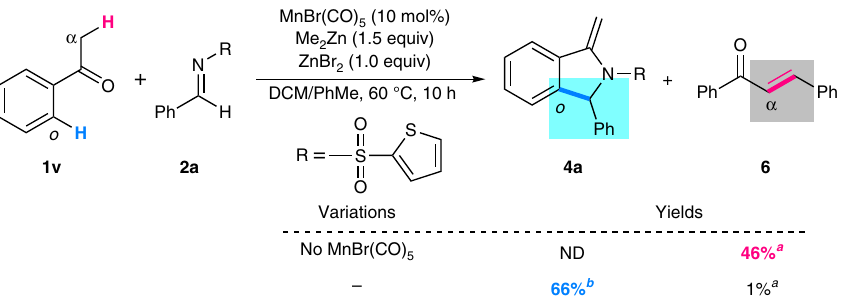
Fig. 2 Evaluating the C – H bond selectivity of ketones by manganese-based catalytic system. a GC-MS yield. b Isolated yield. DCM dichloromethane, ND